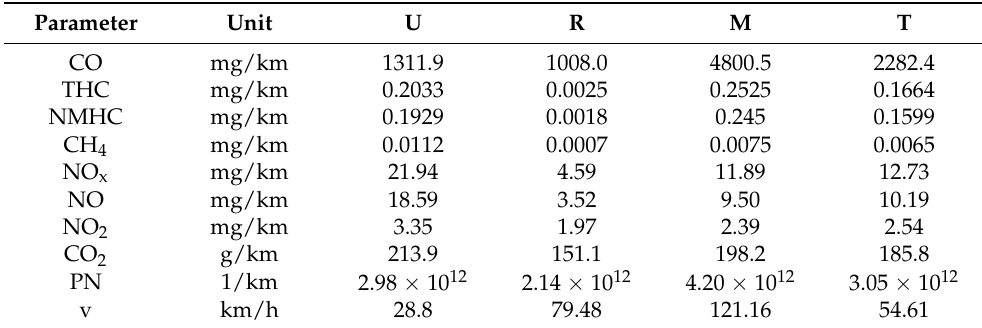
Table 3. Mean road emissions, mean road number of emitted particles and average vehicle speed from the individual test phases and from the entire RDE